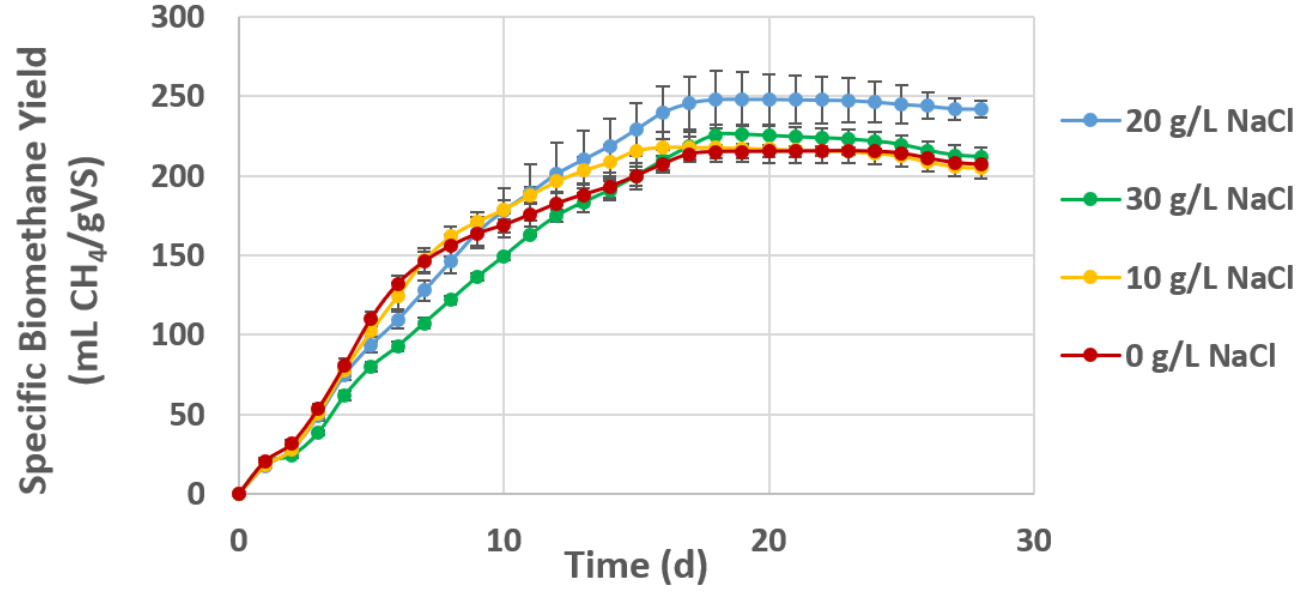
Figure 2. Cumulative BMP of S. europaea cultivated under hydroponic conditions at different salinity concentrations (0, 10, 20 and 30 g/L NaCl). Values of each curve represent the average biomethane yield and standard deviation of triplicate BMP batch assays.